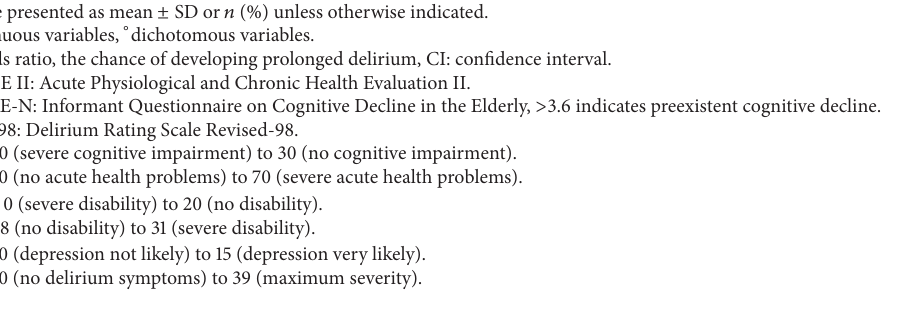
Table 2: Presence of individual DRS-R-98 delirium symptoms on first day of delirium. DRS-R-98 item Short delirium ( 𝑛 = 22